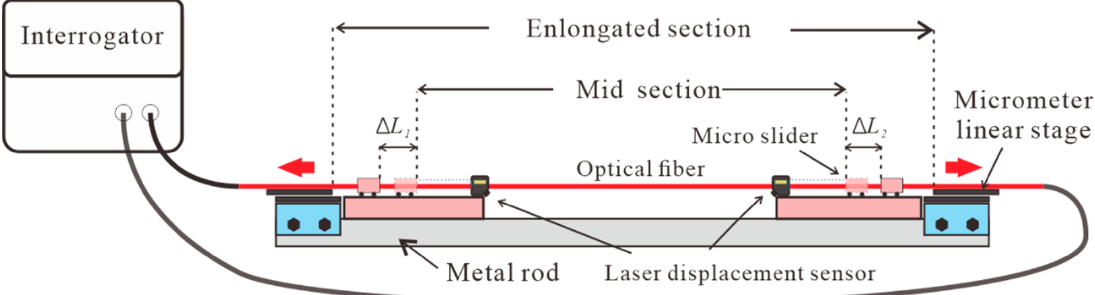
Figure 2. Schematic diagram of the improved calibration setup.